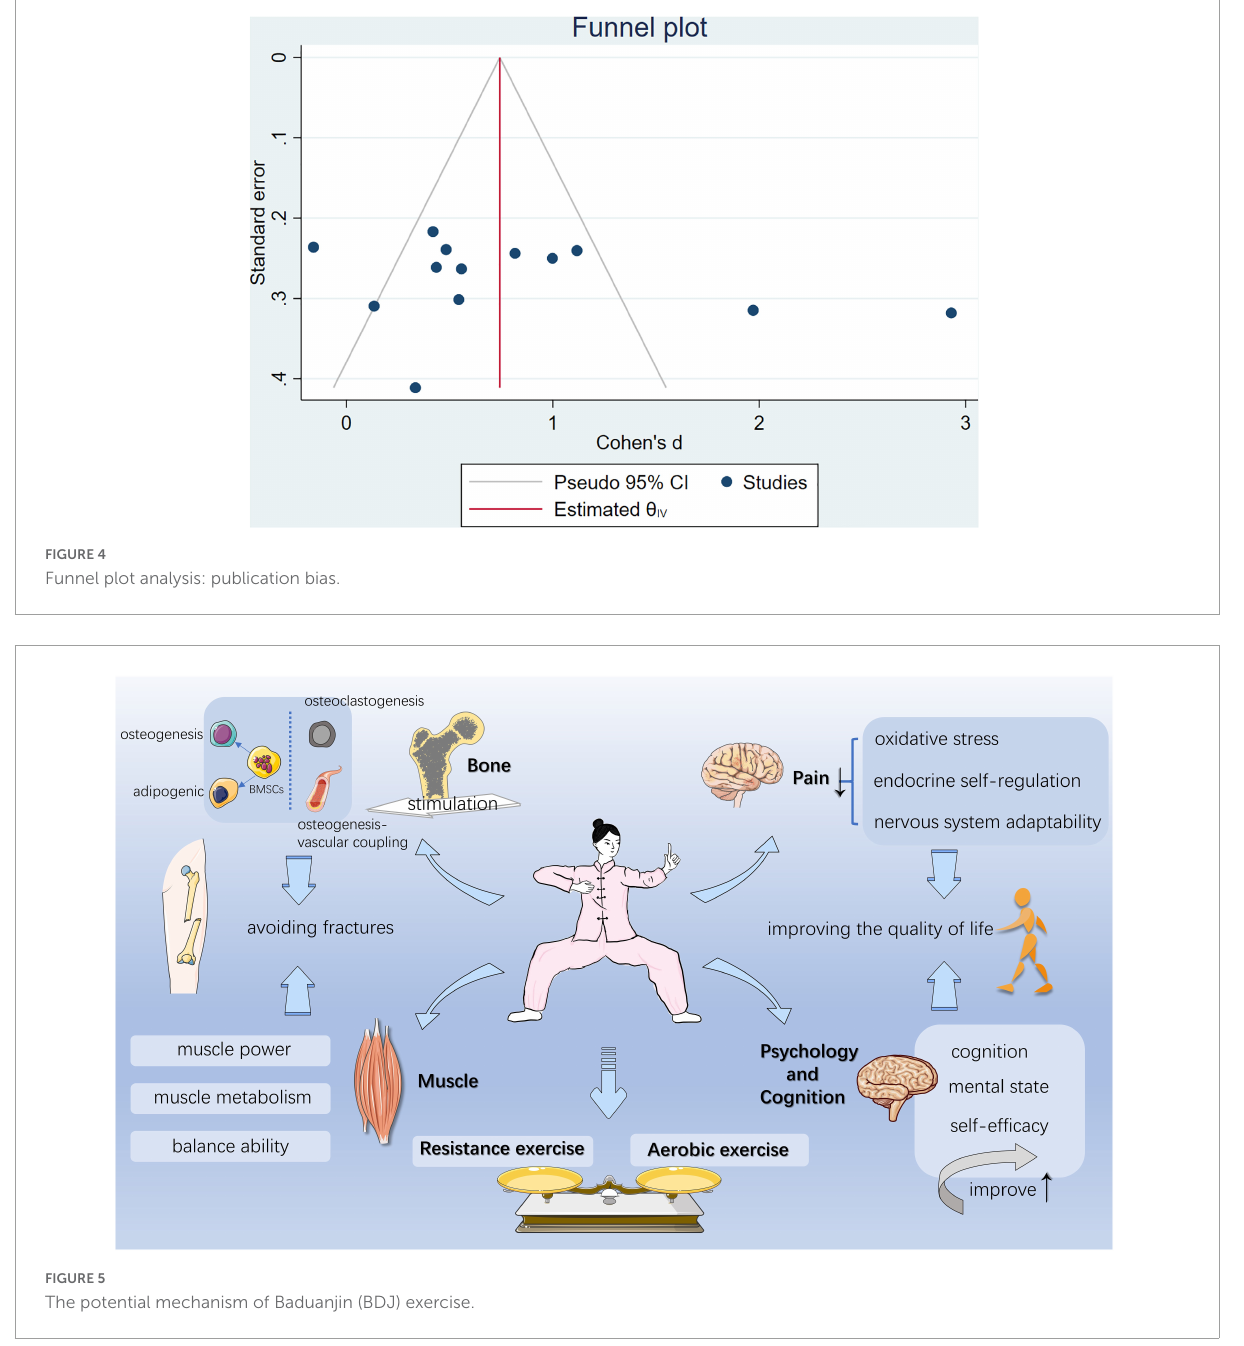
(which has been shown to trigger bone remodeling), apoptosis occurs in osteoblasts located near the site of microdamage, which is associated with increased bone remodeling due to increased RANKL production and increased osteoclast formation